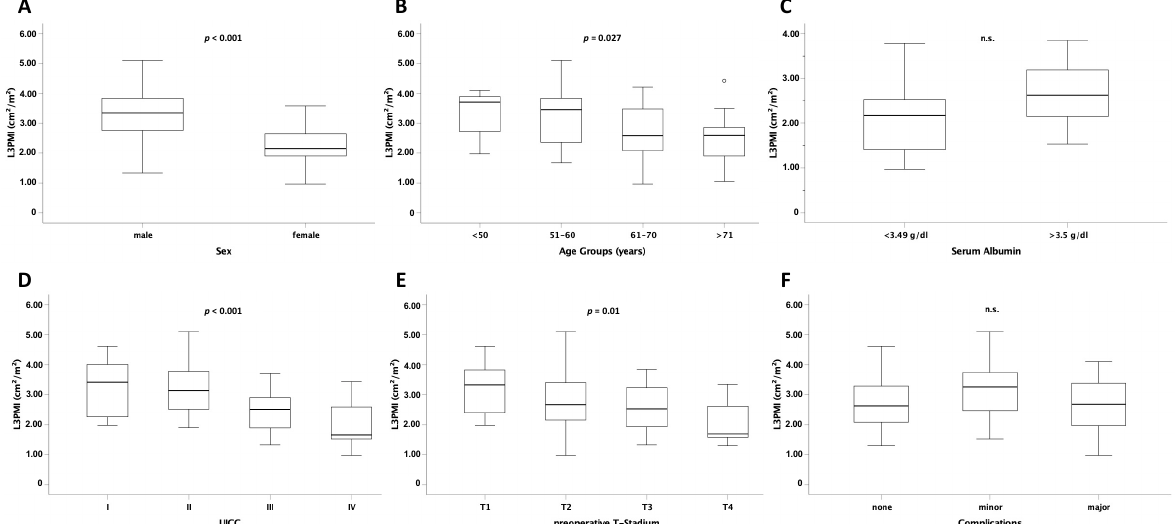
Figure 3. L3PMI is dependent on age, sex, and preoperative T and UICC stage. L3PMI was significantly different in male and female patients ( A ), different age groups ( B ), and UICC stage ( D ) as well as T stage ( E ). For albumin serum concentration ( C ) and postoperative complications ( F ) no significantly different L3PMI levels were observed. Box plots show medians, quartiles, and ranges; ° = outlier; n.s. = not significant.